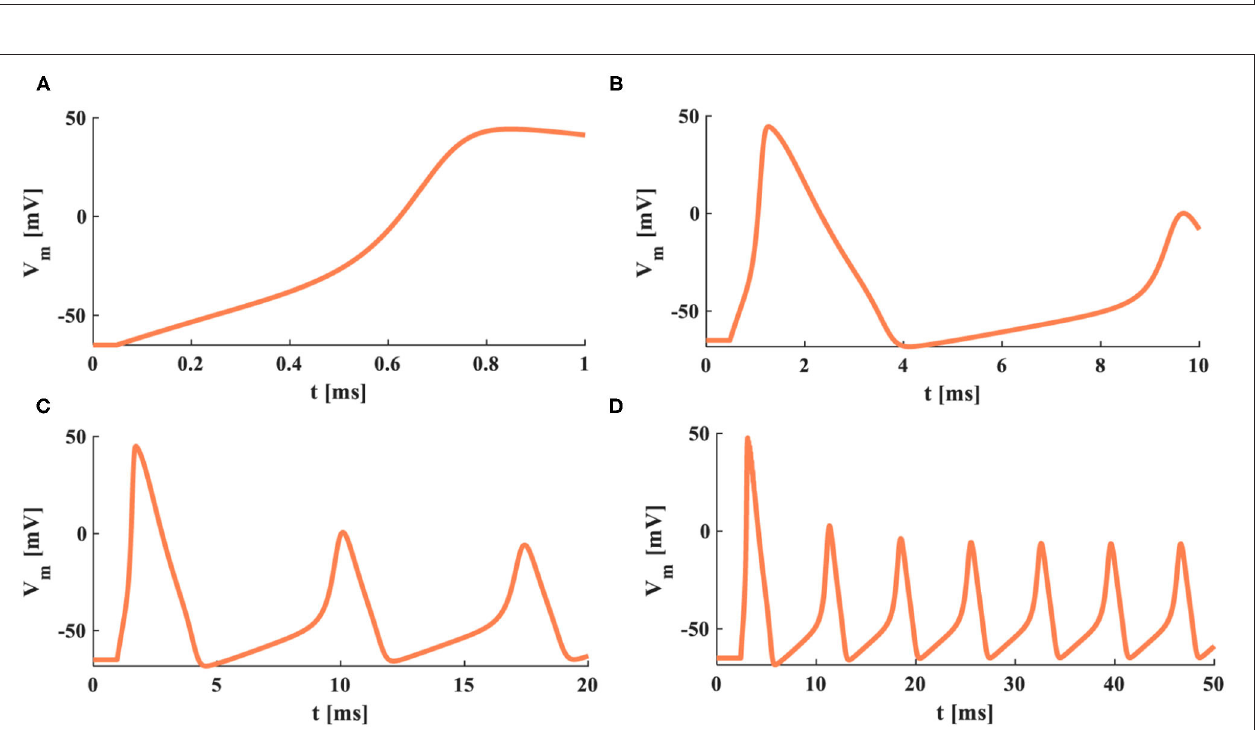
FIGURE 7 | The firing behaviors under the various action time of the external stimulus. (A) The action time is 1 ms. (B) The action time is 10 ms. (C) The action time is 20 ms. (D) The action time is 50 ms.